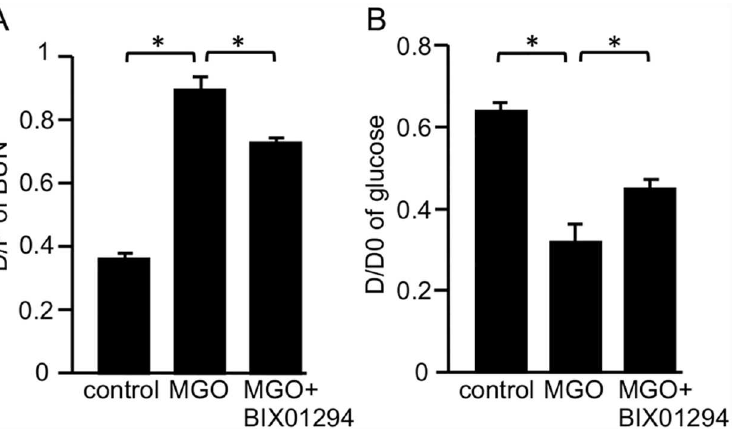
Fig 6. BIX01294improves functional impairments of the peritoneal membrane in mice with peritoneal fibrosis. Graph shows (A) the dialysate-to-plasma(D/P) ratio of blood urea nitrogen(BUN) and (B) peritoneal absorption of glucosefrom the dialysate(D/D0) in control mice, MGO-injected mice, and MGO-injected mice treated with BIX01294duringthe 10-minute dwellof dialysate(4.25% Dianeal).Data are expressedas the mean ± SE. Statistical analysiswere performed by analysisof variance followedby Tukey’s post-hoc test. * P < 0.05, n = 5 mice per